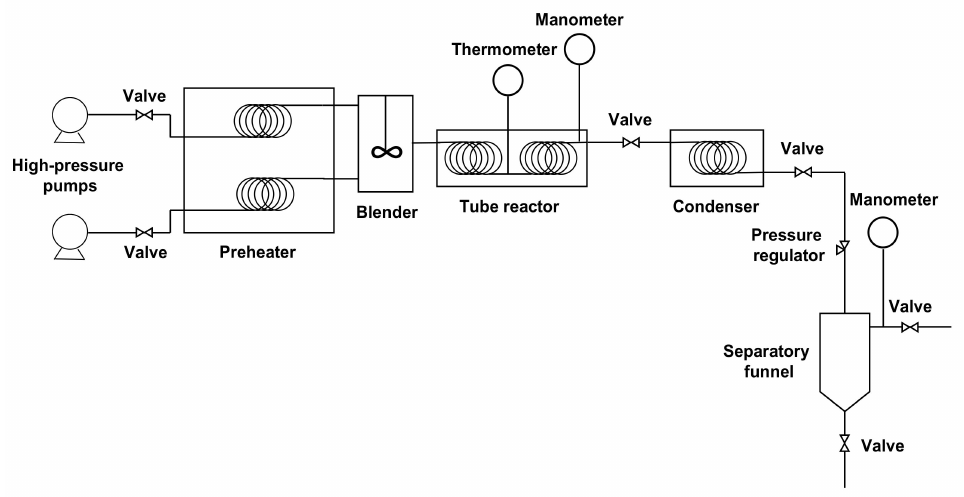
Figure 24. Supercritical continuous reaction